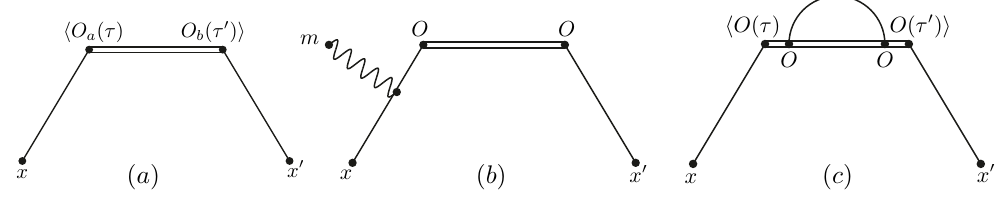
Figure 1 . Corrections to the Wightman function order. Diagrams (b), (c) are next-to-leading order in powers of (cid:20) . while for (cid:9) = H , it is the thermal Wightman function at the Hawking temperature T H = 1 = (4 (cid:25)r s